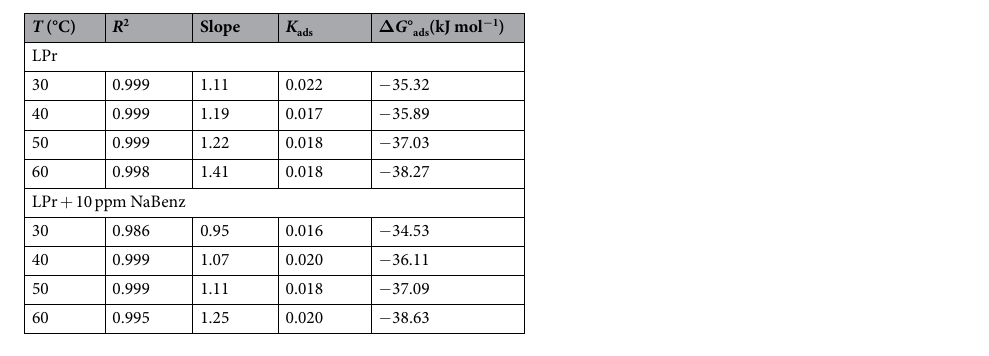
Table 6. Thermodynamic parameters of adsorption for MS in 1M HCl at 30–60 °C obtained from Langmuir adsorption